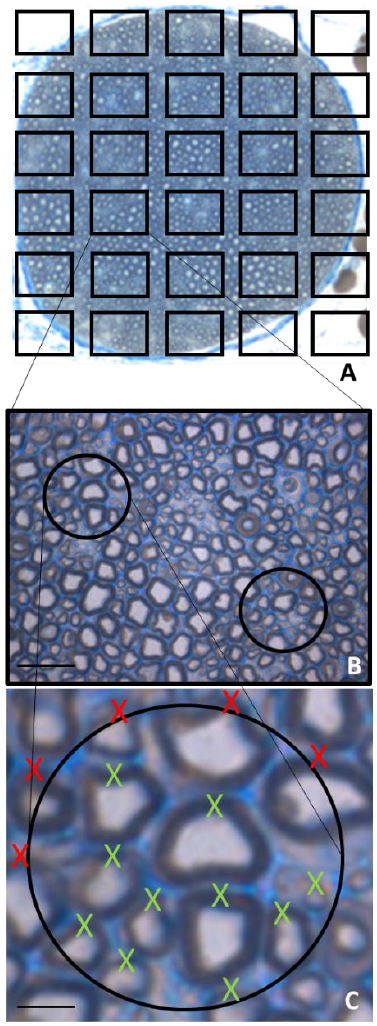
Figure 1. Representative scheme of morphometric procedures for the quantitative analysis of myelinated nerve fibers on a semithin transvers section stained with toluidine blue. ( A , B ) Systematic random sampling rules representation; ( C ) 2D dissector method based on sampling the “tops” of fibers, avoiding the “edge effect”. X red: fiber not counted. X green: fiber counted. Scale bars: 20 μ m ( B ); 5 μ m ( C ).